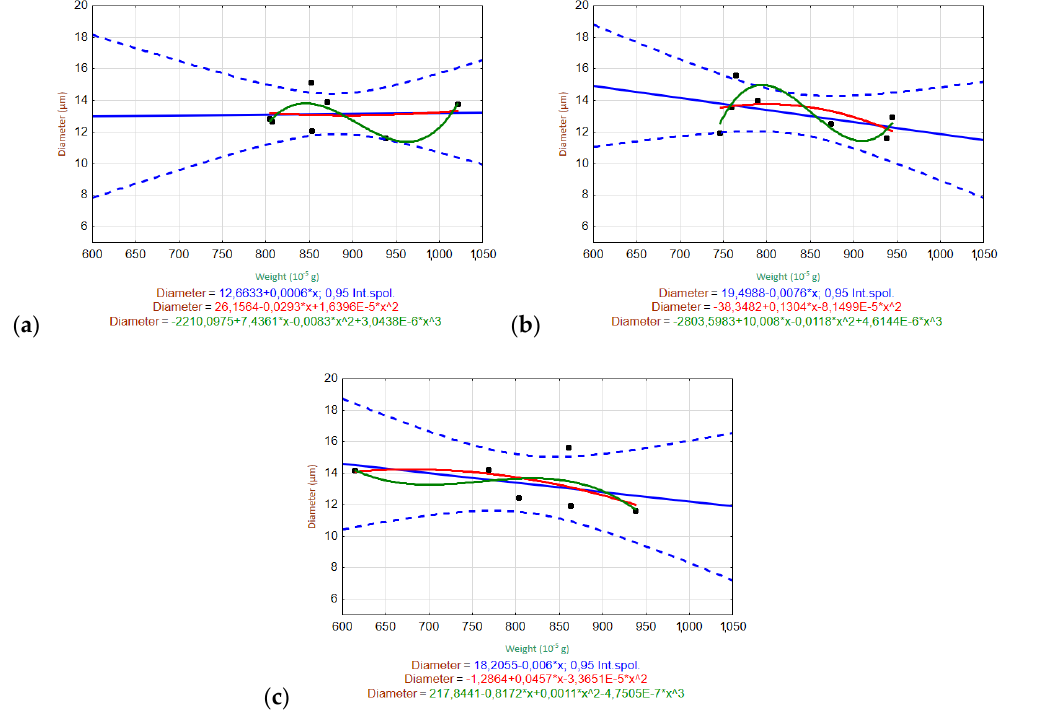
Figure 10. Scatter plots of the relationship between the fiber diameter and weight of ARGFs treated with different solutions: ( a ) H 2 O, ( b ) Ca(OH) 2 , and ( c ) K 2 SiO 3 (bottom).